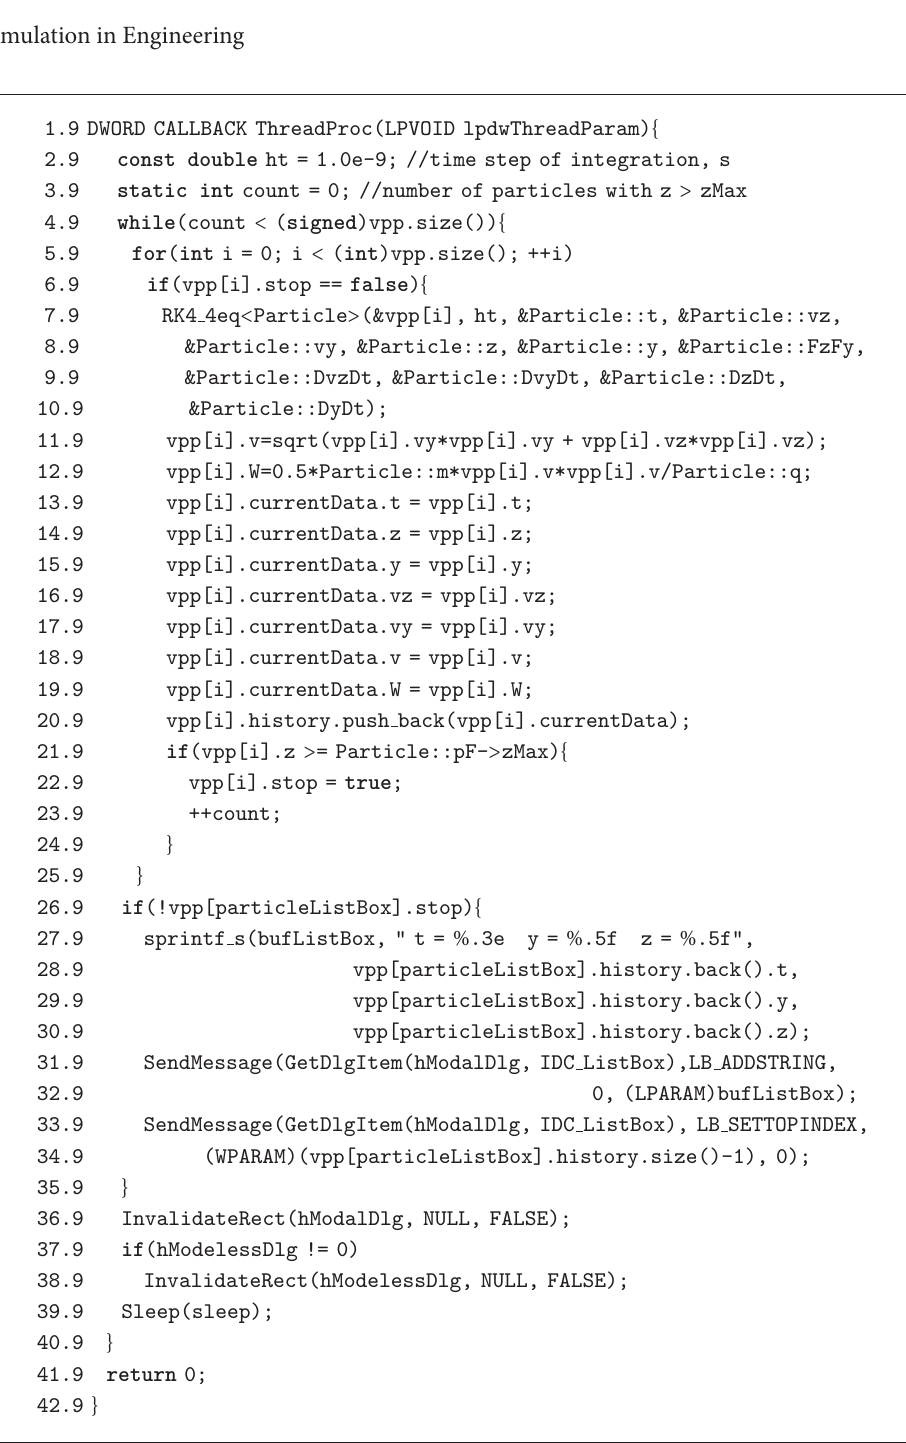
Algorithm 9: The second thread: function ThreadProc